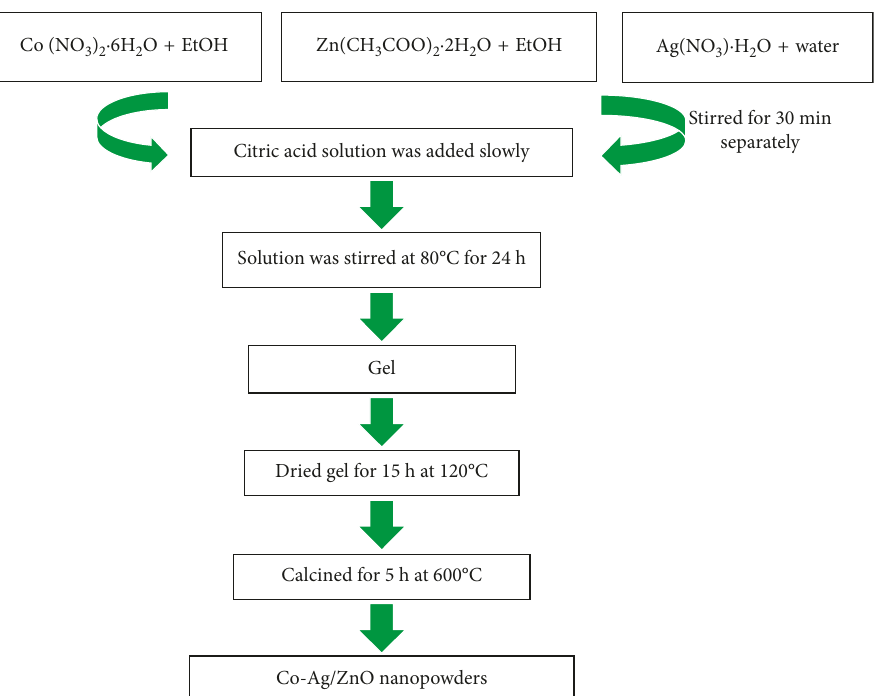
Figure 1: Flow chart for synthesis of Co-Ag/ZnO nanopowders by a sol-gel